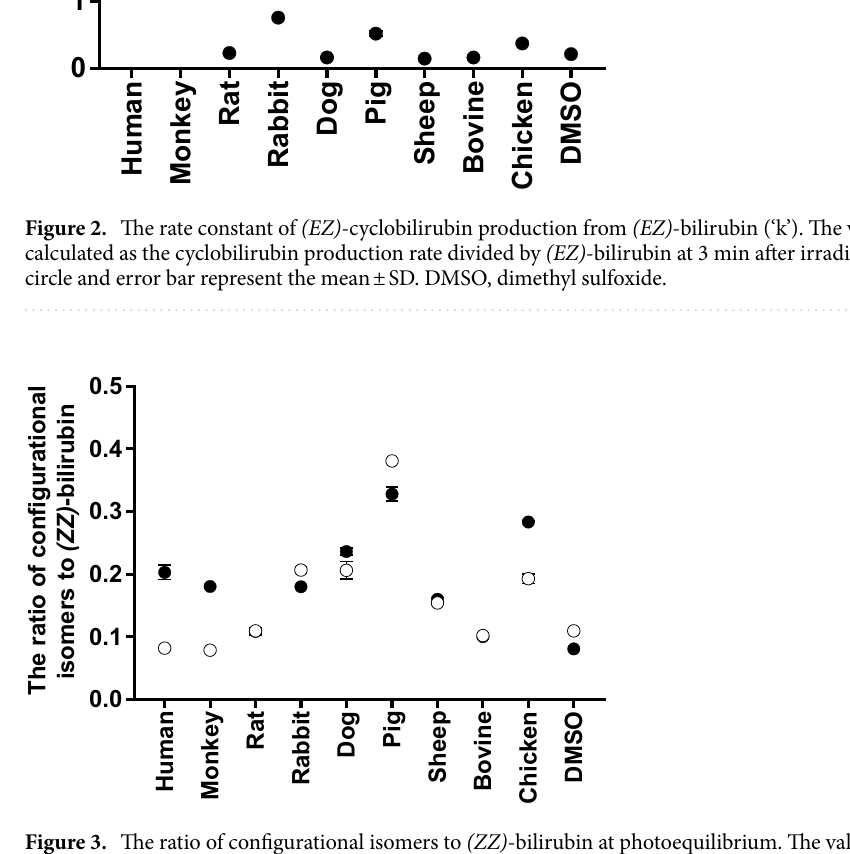
Figure 3. The ratio of configurational isomers to (ZZ) -bilirubin at photoequilibrium. The values of (ZE) - bilirubin and (EZ) -bilirubin were in a state of photoequilibrium with (ZZ) -bilirubin at 3 min. The closed circle represents the (ZE) -bilirubin/ (ZZ) -bilirubin ratio, and the open circle represents the (EZ) -bilirubin/ (ZZ) - bilirubin ratio. Each circle and error bar represent the mean ± SD. DMSO, dimethyl